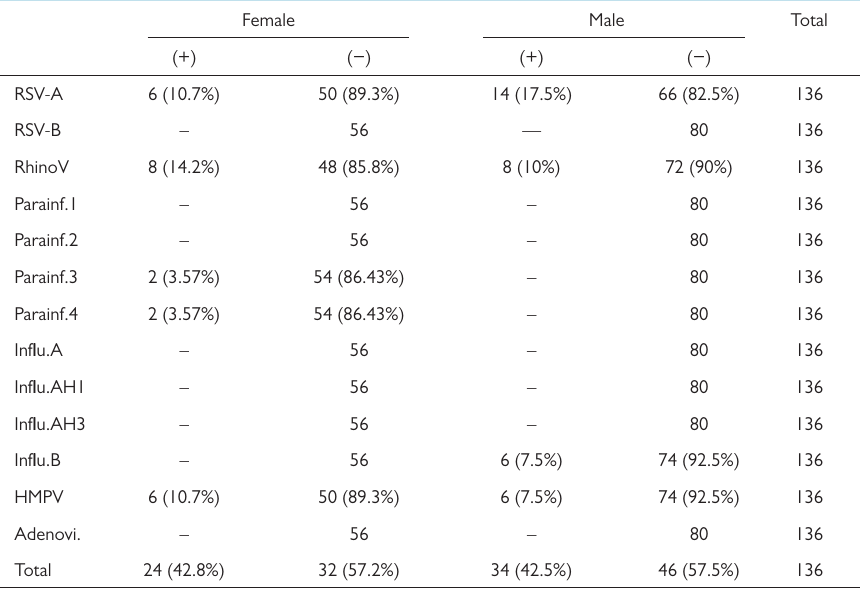
Table 4. Distribution of the Viral Respiratory Tract Pathogens by Sex